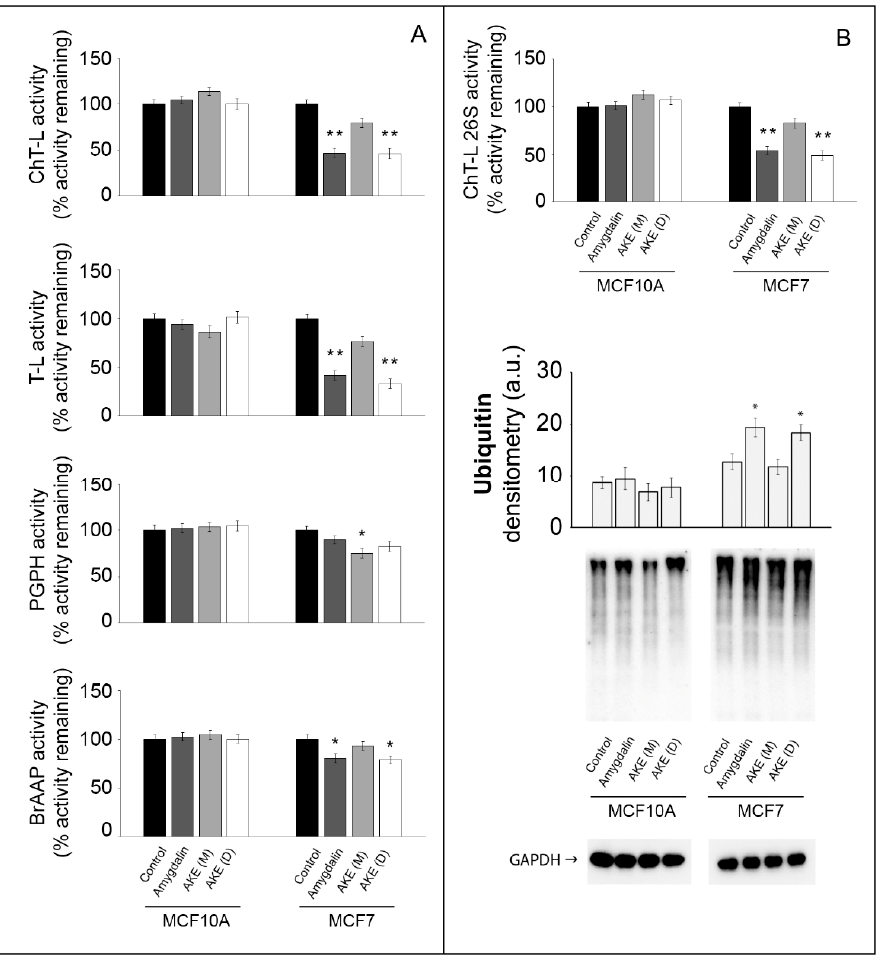
Figure 3. Effect of amygdalin and apricot kernel extracts on the 20S and 26S proteasome functionality. ( A ) 20S proteasome activities in normal and cancer cells following 24 h treatment with 50 μ M amygdalin and 1 mg/mL apricot kernel extracts. Asterisks indicate significantly different values compared with respective untreated control cells (* p < 0.05, ** p < 0.01). Results are expressed as mean values and standard deviation and are obtained from five separate experiments. ( B ) 26S ChT-L proteasome activity in treated cells and a representative Western blot of ubiquitin-conjugates with the relative densitometry. GAPDH was used as equal loading control. * p < 0.05, ** p < 0.01 indicates significantly different values compared with respective untreated control cells. Results are expressed as mean values and standard deviation and are obtained from five separate experiments.